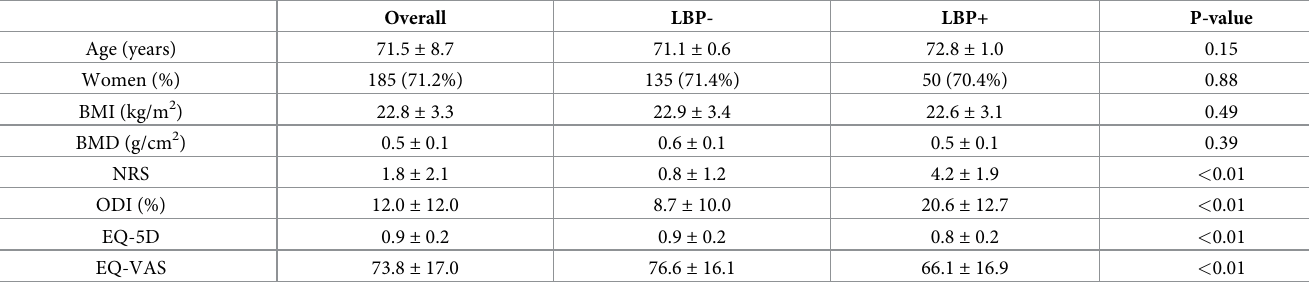
Table 1. Participants’ characteristics according to the presence of low back pain.